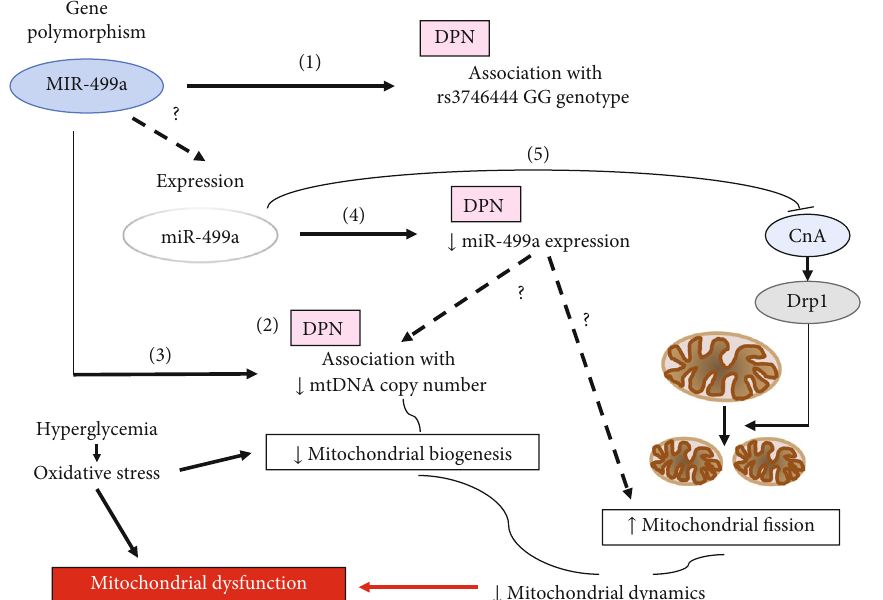
Figure 1: MIR499A polymorphism and miR-499a expression in DPN: hypothesis for a pathogenetic role in DPN. Mitochondrial dynamics are a continuous process of fusion, fi ssion, biogenesis, and mitophagy that in neurons contrasts hyperglycemia-driven oxidative stress and maintains cellular bioenergetics [64, 73]. Mitochondrial dysfunction derives from persistent increase in metabolic load and oxidative stress in neurons in diabetes and is considered a relevant mechanism in the pathogenesis of DPN [65, 73]. Both dysregulation of the fi ssion/fusion balance with increased fi ssion and impaired biogenesis with reduced number of mtDNA have been found in diabetes. Recent studies have shown in people with type 2 diabetes (1) an association of the polymorphism rs3746444 of MIR499A with CAN and DPN [71], (2) a reduction in mtDNA copy number, more pronounced in the presence of DPN [72], (3) an association between this change in mtDNA copy number and the same polymorphism of MIR499A [72], (4) a reduced expression of miR-499a in subjects with DPN [46], and (5) in rat and human cardiomyocytes that miR-499a targets the gene of calcineurin (CnA), inhibits its expression and the CnA-mediated activation of dynamin-related protein (Drp) 1 responsible for mitochondrial fi ssion and apoptosis [59, 60]. These fi ndings allow the hypothesis that MIR499A polymorphism and changes in expression and function of miR-499a might a ff ect both mitochondrial biogenesis and increase mitochondrial fi ssion thus altering mitochondrial dynamics and leading to mitochondrial dysfunction and to DPN. It is not documented (dashed lines) that the studied MIR499A polymorphism a ff ects miR-499 expression, and that in DPN, the reduced miR-499a expression is related to decreased mtDNA copy number and increased mitochondrial fi